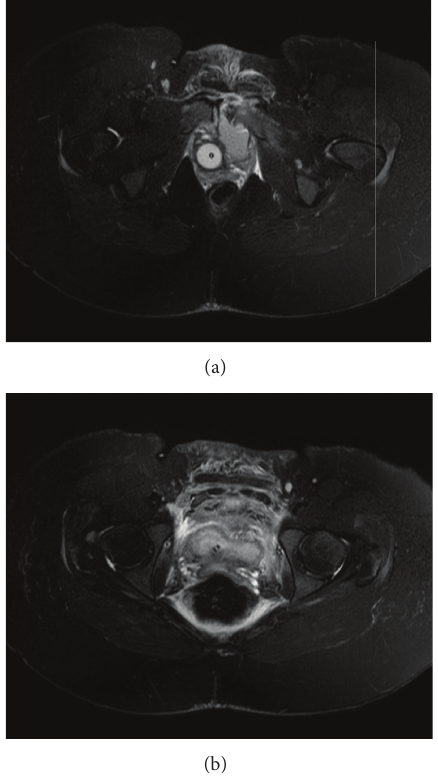
Figure 3: Axial T2-weighted images with fat-saturation (SPIR) are shown in (a) and (b). In addition, a hematoma around the symphysis pubis is shown, which extends to the small